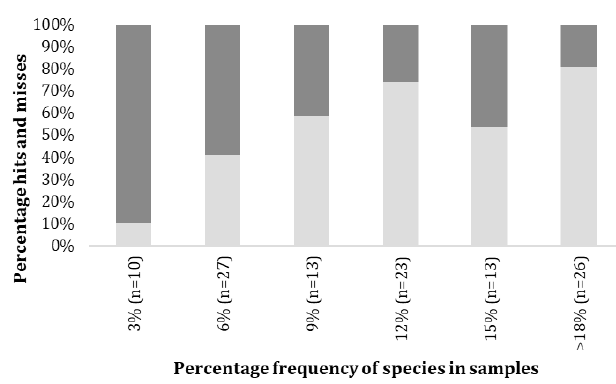
Fig 2 . Sensitivity of the Next Generation Sequencing technique, illustrated by showing the rate at which a species was detected in preserved Barrow Island ant material. The “Hit” (light part of bar) shows the degree of success relative to the frequency at which that particular ant species occurred within the